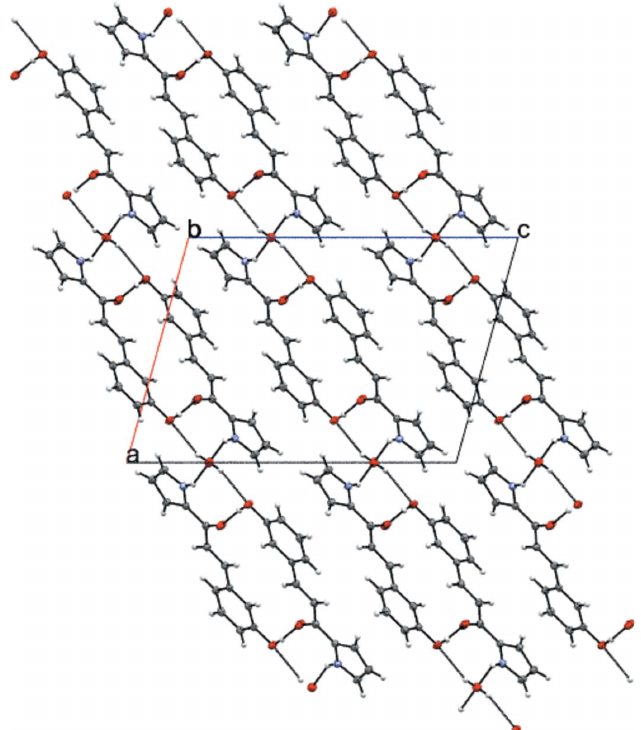
Figure 2 The crystal packing of compound 3HPPP viewed along the b axis. The intermolecular interactions are indicated by dashed lines.